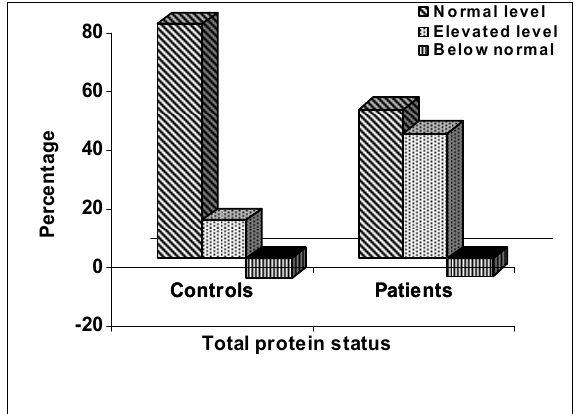
Figure 1: Percentages of the populations of the control subjects and arsenicosis patients with normal, elevated, and below normal levels of total protein in serum.